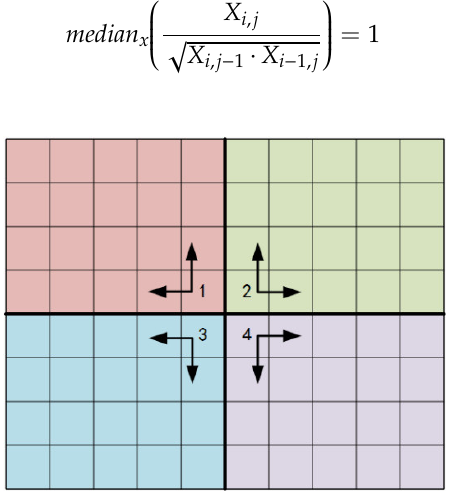
Figure 1. Adjacent pixels schematic.